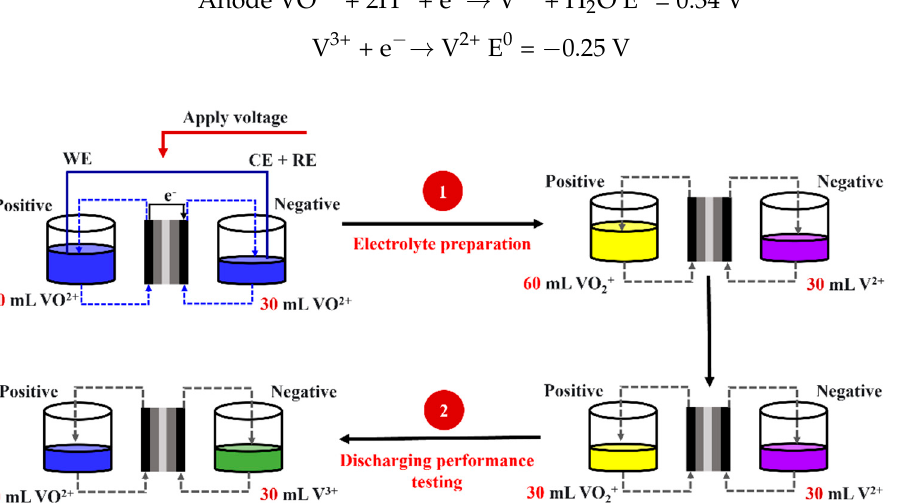
Figure 3. Flow chart of electrolyte preparation and discharging performance.